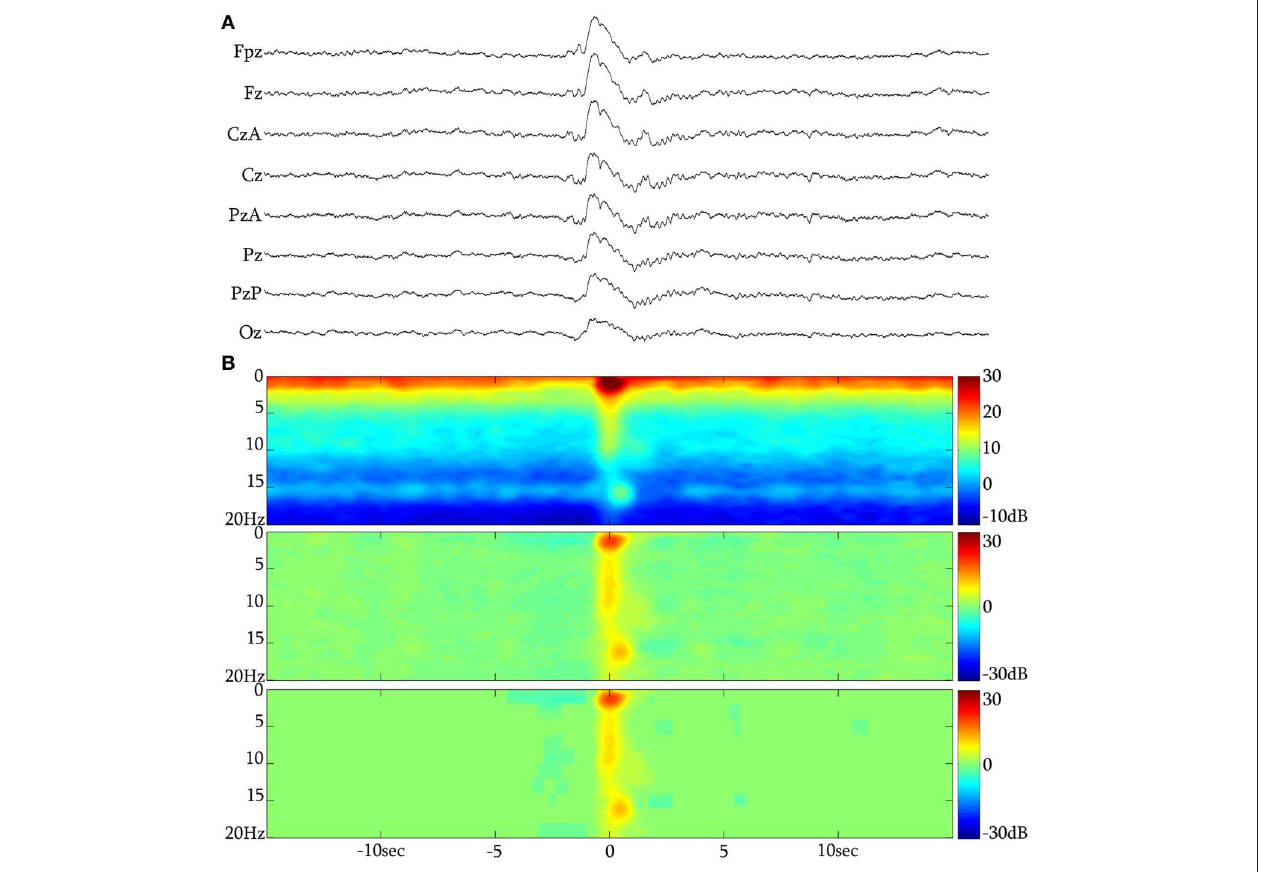
FIGURE 2 | (A) The KC over the NREM background. (B) Long time-range average spectrogram (up), event-related spectral perturbation (middle) and statistically significant changes with respect to a − 15 to − 5s background (low) in triplets for a grand-average of 313 unclustered KCs from subject 1.